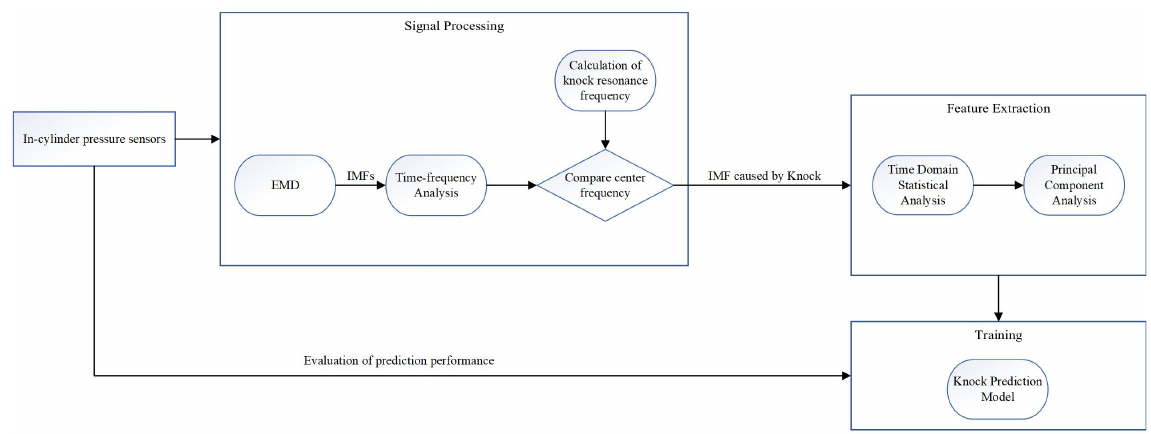
Figure 5. Kerosene engine knock-prediction framework and work fl ow.